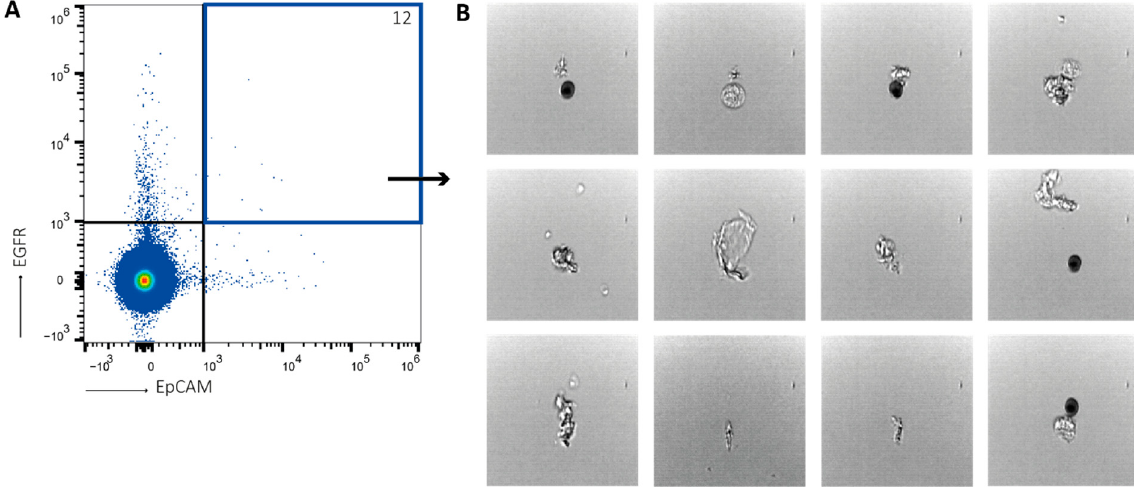
Figure 5. Patient EpCAM+EGFR+ cells have no tumor cell-like morphology. Blood analysis of cancer patients. After PBMC isolation, samples were stained for EpCAM and EGFR, and analyzed using the Attune CytPix. ( A ) Tumor cells were detected by EpCAM+EGFR staining. ( B ) EpCAM+EGFR+ cells have no tumor cell-like morphology. Number of detected tumor cells is indicated in upper right corner. Representative figure of N = 15.